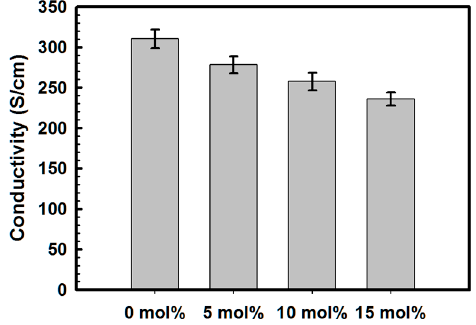
Figure 3. Conductivity of PEDOT:P(SS- co -VTMS) with DMSO solution treatment.